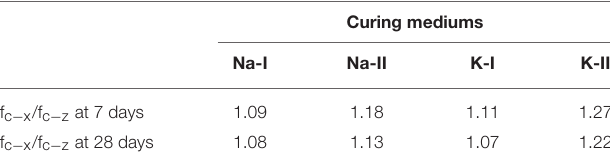
TABLE 6 | Anisotropy in the compressive strength of the ambient temperature cured 3D printed